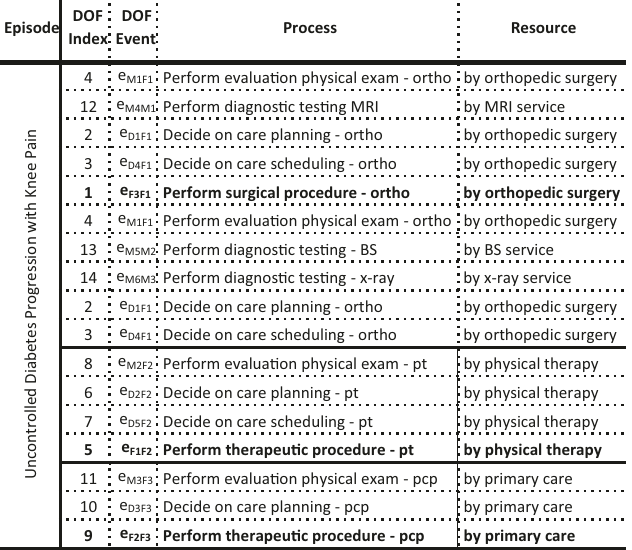
Figure 14: Diabetes Chronic Episode A described in terms of the healthcare delivery system events found in 𝐽 𝐹𝐷𝑀 . The healthcare delivery transformational events are in bold.